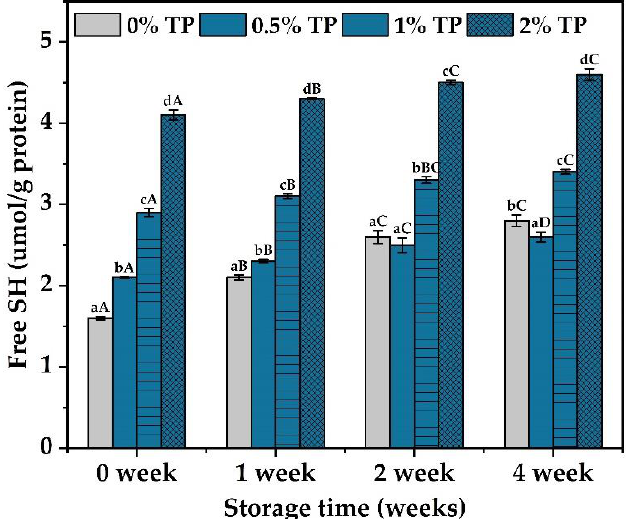
Figure 4. Sulfhydryl contents of gluten at 0 to 4 weeks, stored at −20 °C with various TP additions. Each experiment was carried out in triplicate. Values with different lower- or uppercase letters differ significantly among samples, either with the same frozen storage time or TP addition ( p < 0.05).